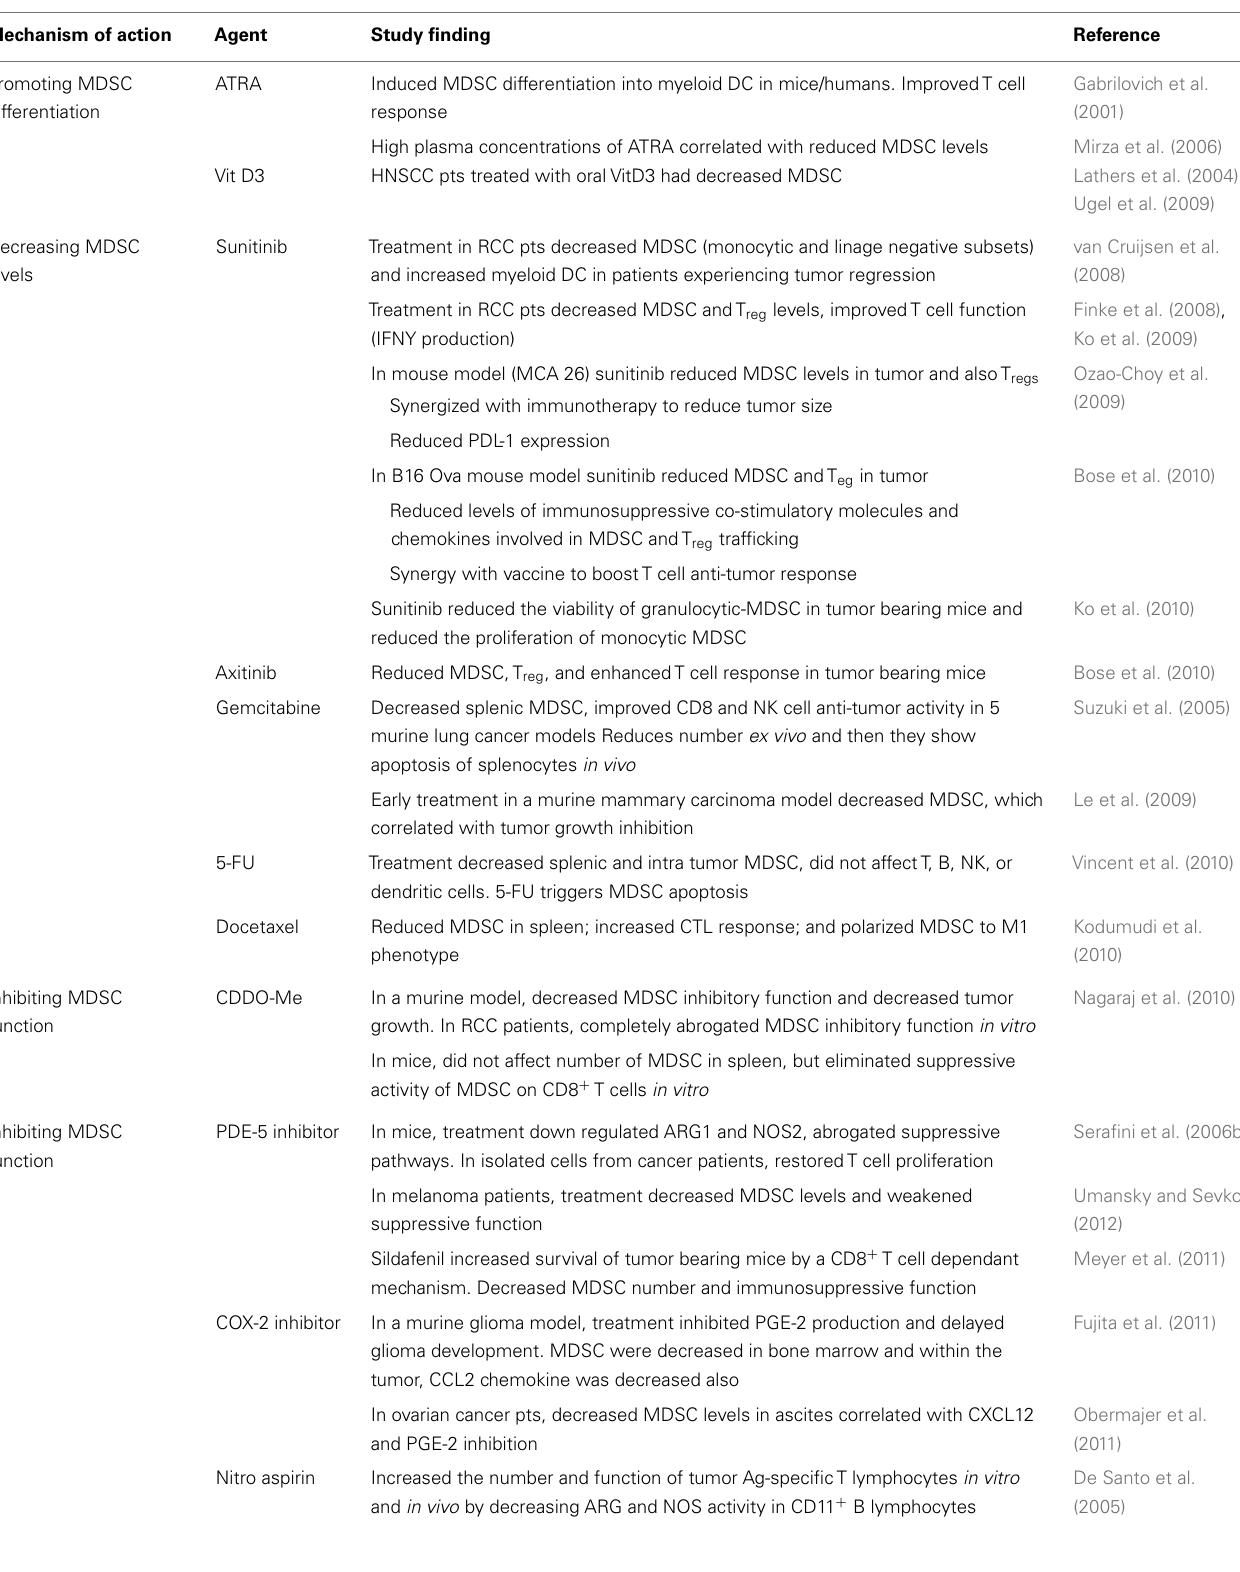
Table 1 | Summary of mechanisms of anti-MDSC agents and key study